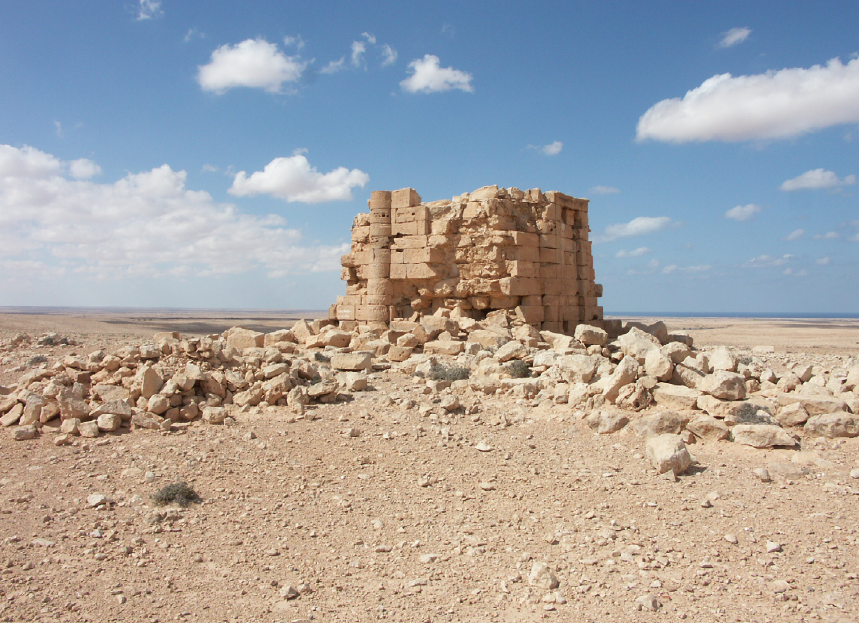
Fig. 13. Orientation along the routes with man-made markers: Borg el Qasaba, a monument on the Northern Tableland, 28 km east of Marsa Matruh from Graeco-Roman times. (Alexander Nicolay).